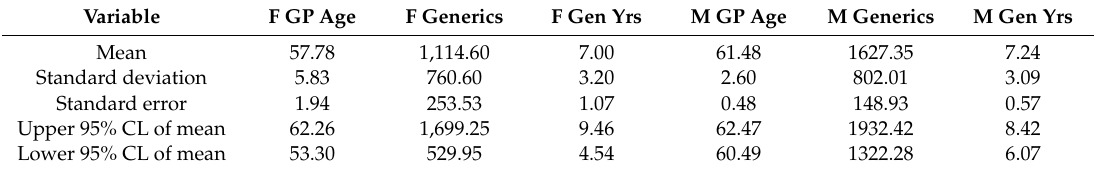
Table 3. Descriptive statistics for generic drug prescription by GPs